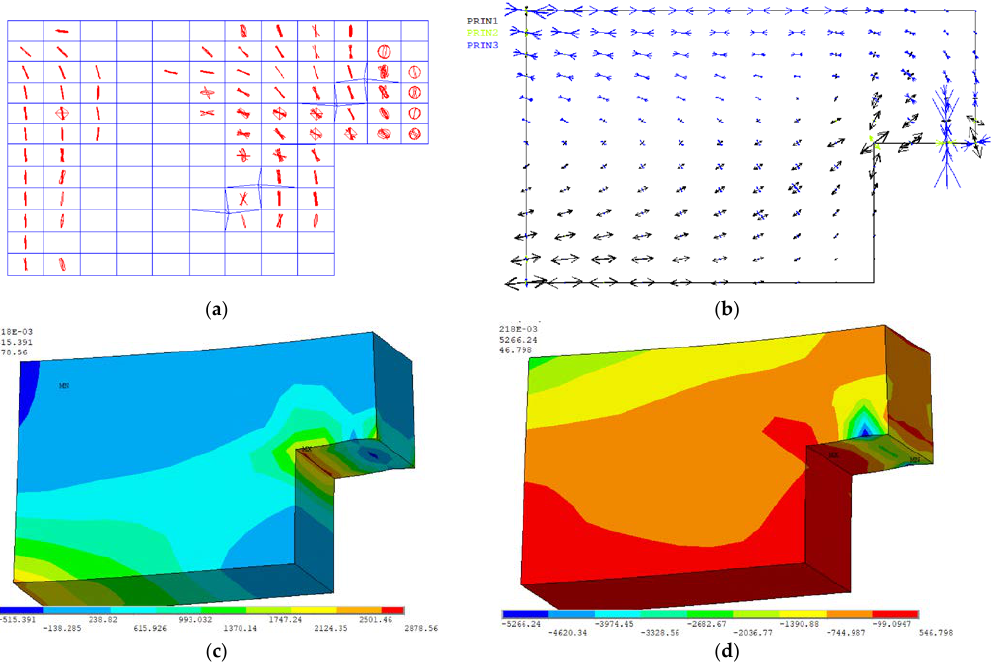
Figure 15. Half-joint without steel reinforcement. ( a ) Cracking surfaces at collapse (78% final load); ( b ) vector plot of principal stresses just before collapse; ( c ) 1st principal stress just before collapse [kN/m 2 ]; ( d ) 3rd principal stress just before collapse [kN/m 2 ].